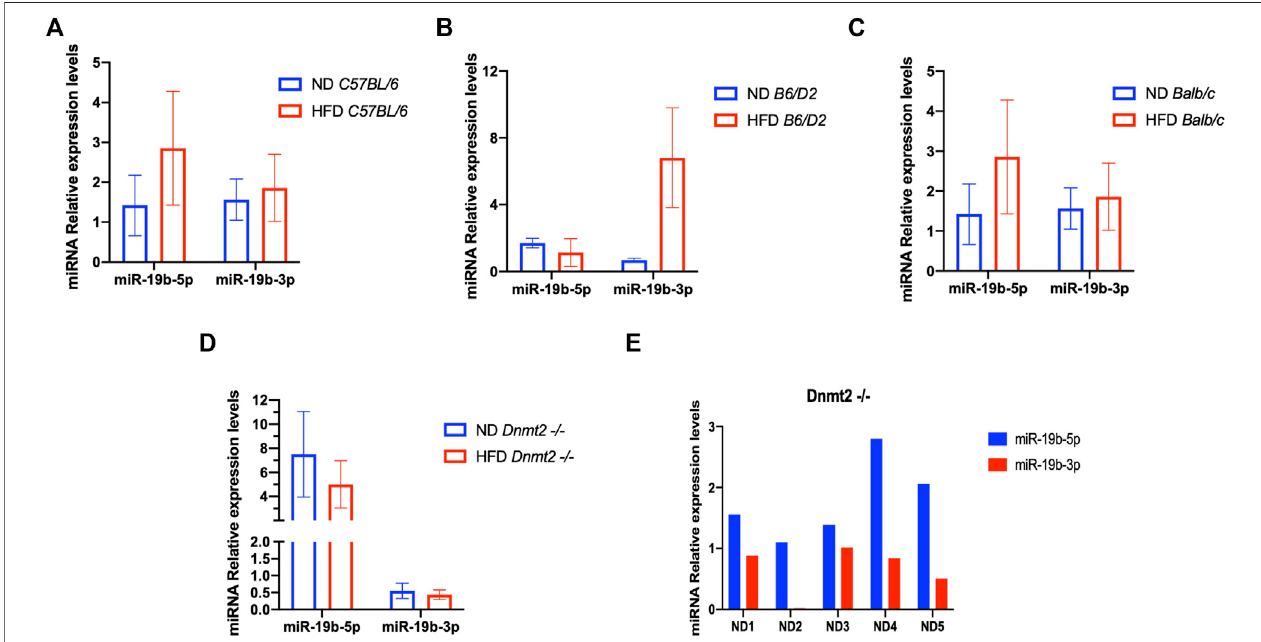
FIGURE 4 | Level of miR 19b in the total sperm RNAs of different lines founders mice ( C57BL/6 , Balb/c, B6/D2 , and Dnmt2 − / − C57BL/6 ) fed with HFD (21% butter). Figure 4 shows the expression levels of miRNA from four males in each group. By quantitative RT-PCR analysis, total sperm RNAs of two ND males compared to two HFD males, in C57BL/6 (A) , B6/D2 (B) , Balb/c (C) , and Dnmt2 − / − C57BL/6 (D) . (E) RT-PCR results for total sperm RNAs from male-to-male in fi ve independent males in